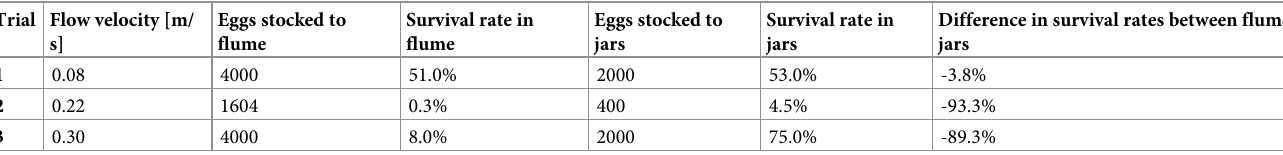
Table 1. Survival rates in RTF and hatching jars after